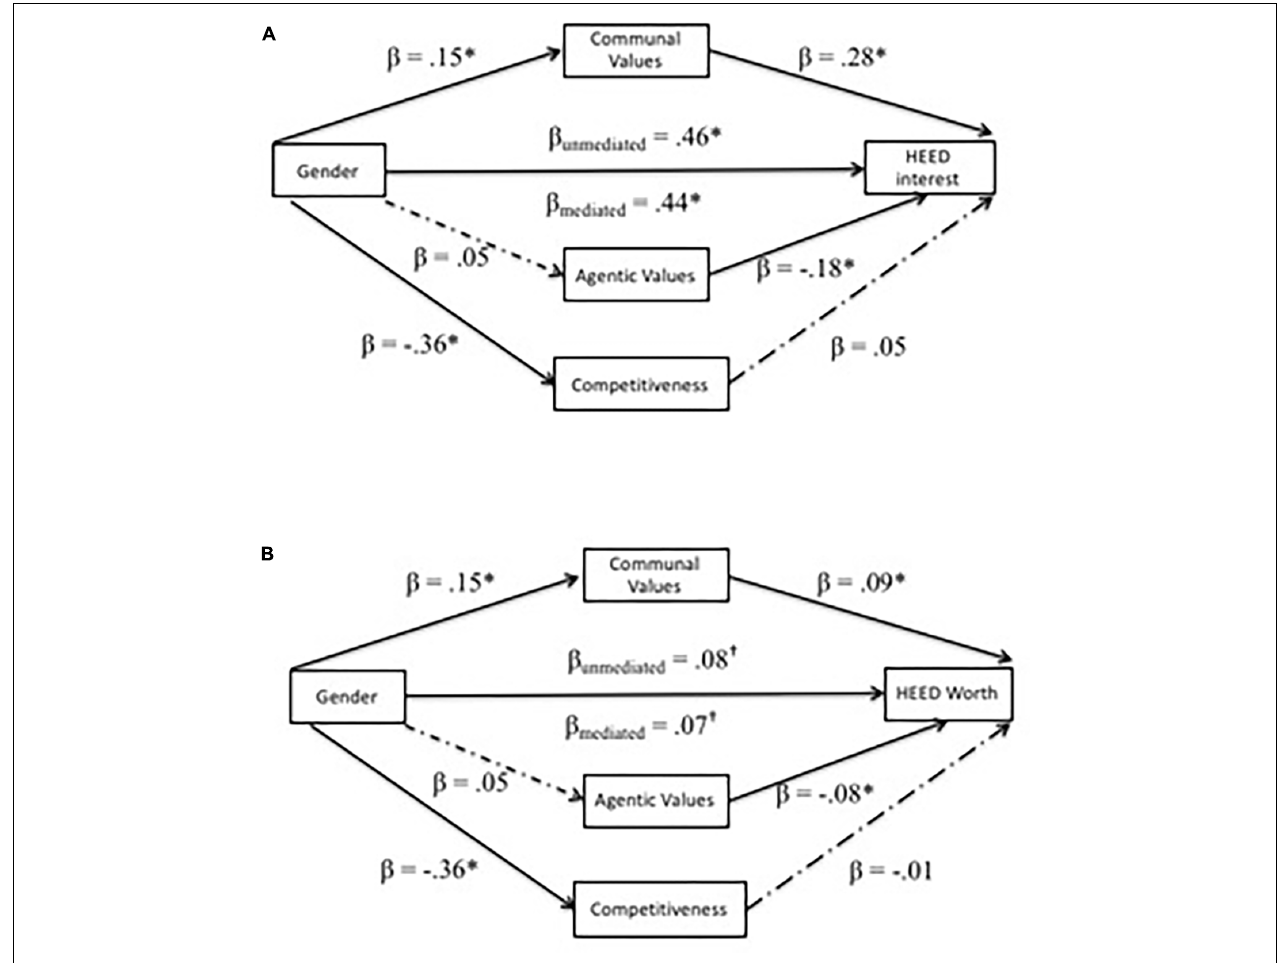
FIGURE 5 | Mediation models for HEED variables in Study 2. (A,B) Show mediation models for HEED related outcome variables. All mediators were entered simultaneously for each model. ∗ p < 0.05, † p < 0.10.